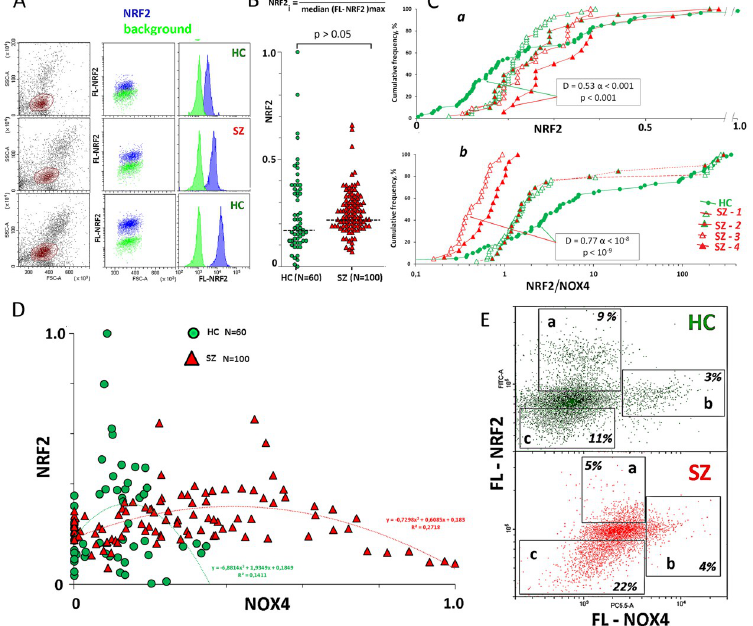
Fig 6. NRF2 levels in the lymphocyte of the SZ and HC groups. A. The most typical examples of the NRF2 analysis in lymphocytes. B. NRF2 levels in the lymphocyte of the SZ and HC groups. The average level of marker in the cell population was estimated by the FL-signal median value. In the graphs, each point is the mean for three FL-signal median values (three parallel measurements for the same PBMC sample). The median values were normalized to the maximum signal medians values in the analyzed total sample (N = 160). The relative standard error was 5 ± 2%. The significance of the observed differences was analyzed using non-parametric Mann–Whitney (p) test. C. (a) Cumulative distribution of NRF2 for HC and SZ subgroups. (b) Cumulative distribution of ratio NRF2/NOX4 for HC and SZ subgroups. D. The dependence of NRF2 on NOX4 for the SZ and HC groups. E. Lymphocyte [HC (green) and SZ (red)] staining with two types of antibodies with different labels: NRF2(FITC) and NOX4(PC5.5).